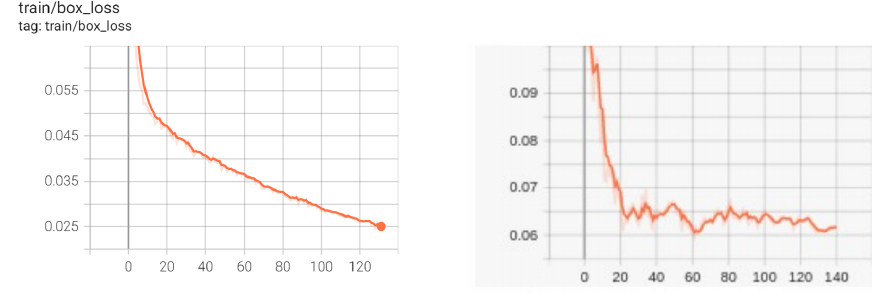
Figure 11. YOLOv5 training and validation